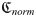
The distribution of Cnorm on all trees in TreeBASE (black line) and its estimated theoretical distribution under the uniform model (red line).